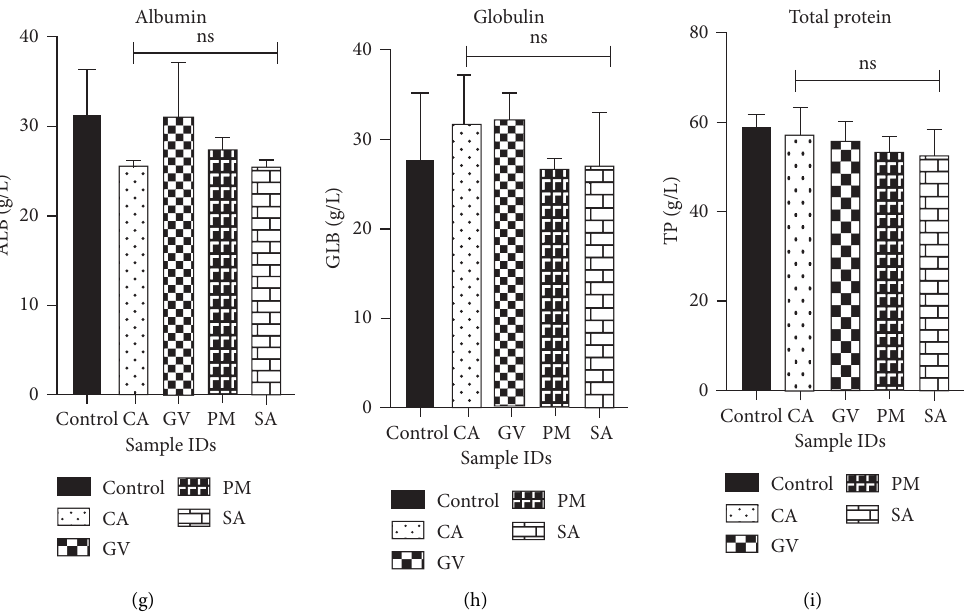
Figure 2: Effect of selected plant extracts on liver function profiles ( n � 3). CA: Celtis africana , GV: Grosseria vignei , PM: Physalis micrantha , SA: Stachytarpheta angustifolia. (a) AST: aspartate transaminase, (b) ALT: alanine transaminase, (c) ALP: alkaline phosphatase, (d) TBIL: total bilirubin, (e) DBIL: direct bilirubin, (f) IBIL: indirect bilirubin, (g) ALB: albumin, (h) GLB; globulin, and (i) TP: total protein. Each bar represents mean ± SEM ( n � 3). p < 0 . 05 was considered to be statistically significant (one-way analysis of variance (ANOVA) followed by Dunnett’s post hoc test).